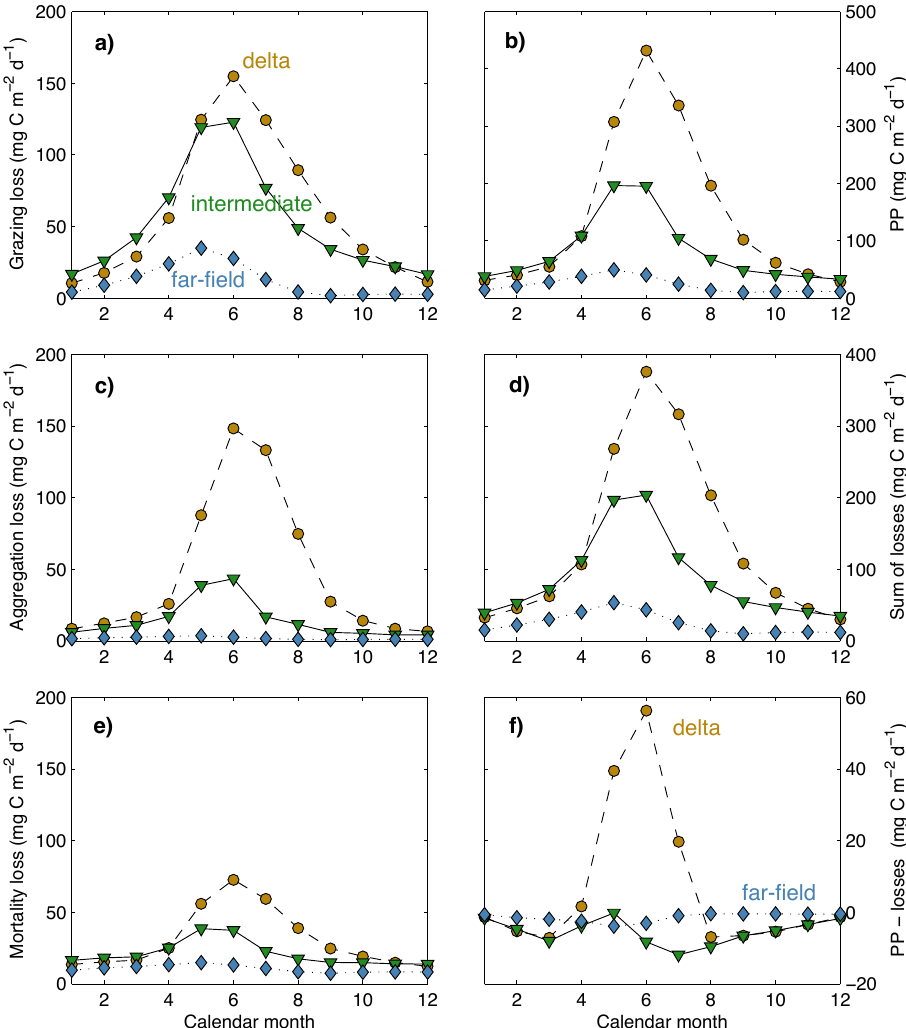
Fig. 14. Monthly climatology of simulated mixed layer mean phytoplankton loss due to grazing (a) , aggregation (c) , and mortality (e) . Also shown is monthly mixed layer mean primary production (b) , sum of the three biological phytoplankton loss terms (d) and balance of primary production and biological loss terms (f) . The losses were converted from units of mmolNm − 3 to mgCm − 3 assuming the Redfield ratio of 106C to 16N and using the molar mass of